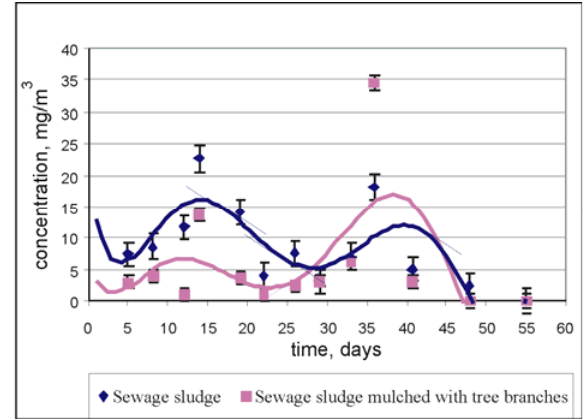
Fig. 19. VOC emissions during composting sewage sludge with minor